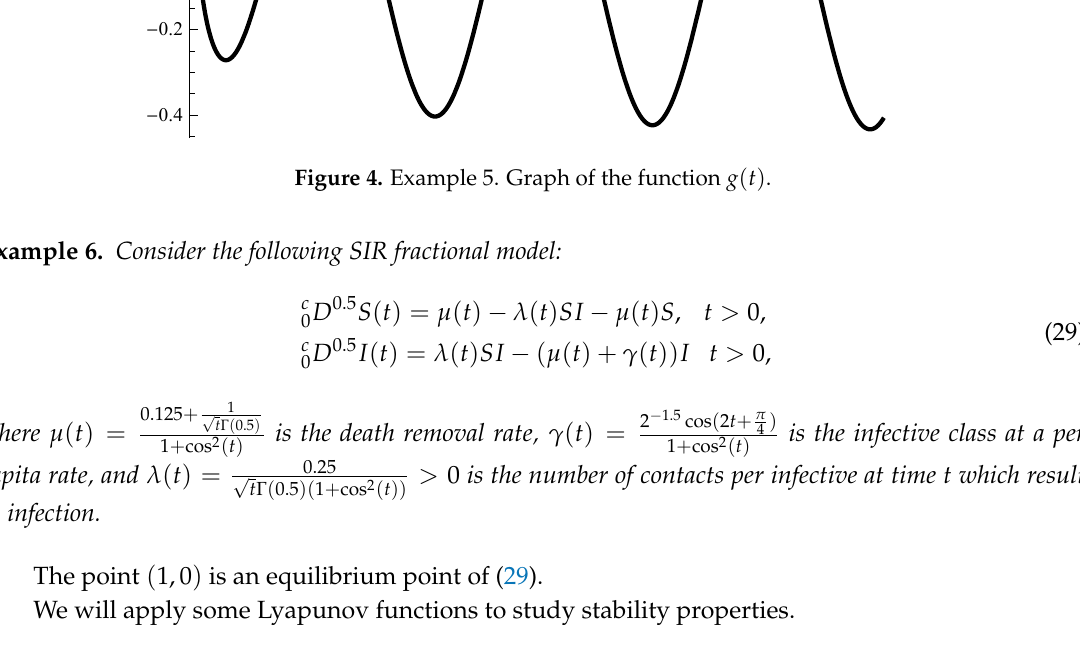
− 0.125 − 0.75 √ − 2 − 1.5 cos ( 2 t + π t Γ ( 0.5 ) 1 + cos 2 ( t )